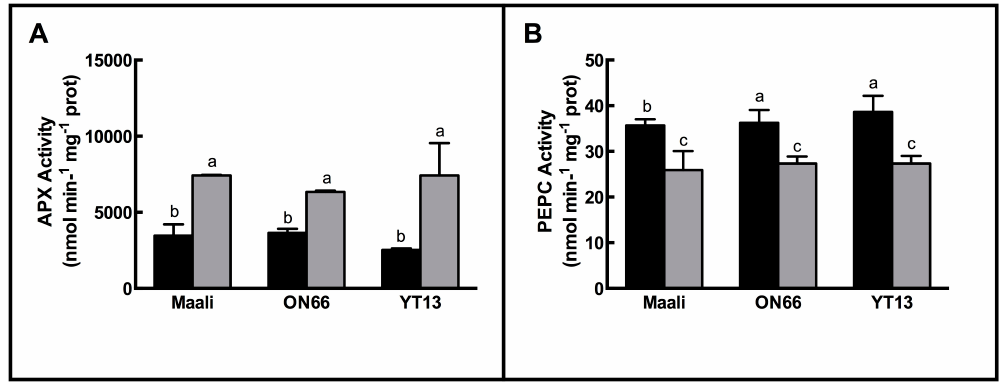
Figure 3. Changes in the activities of APX ( A ) and PEPc ( B ) in durum wheat leaves. Enzymatic rates in control plants are in black bars; activities in stressed plants are in grey bars. Data are the average of at least three determinations ± standard error. Letters indicate homogenous data.